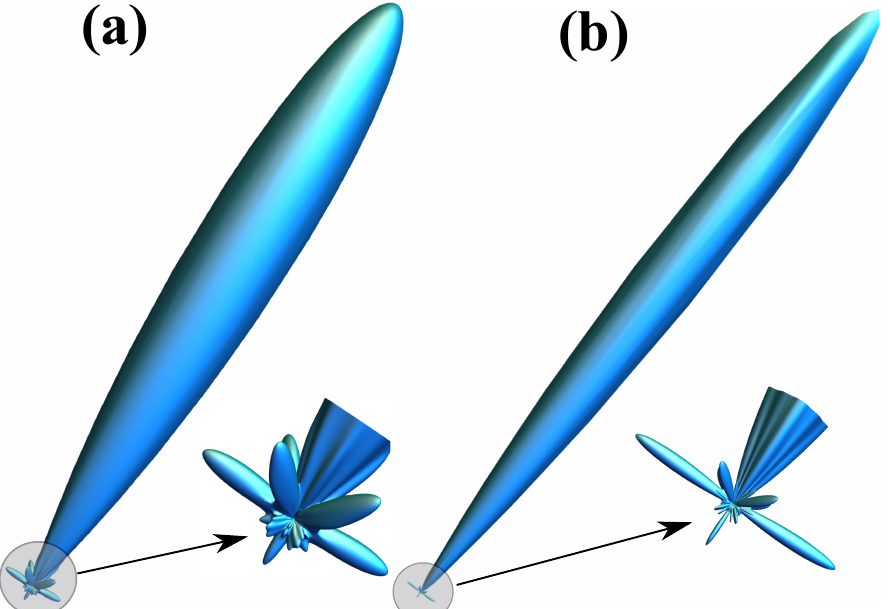
Figure 2. The figures show 3D scattering spectra of the USP: ( a ) the diamond unit cell with NV centre (see Figure 1a) and ( b ) this on the diamond structure shown in Figure 1b.